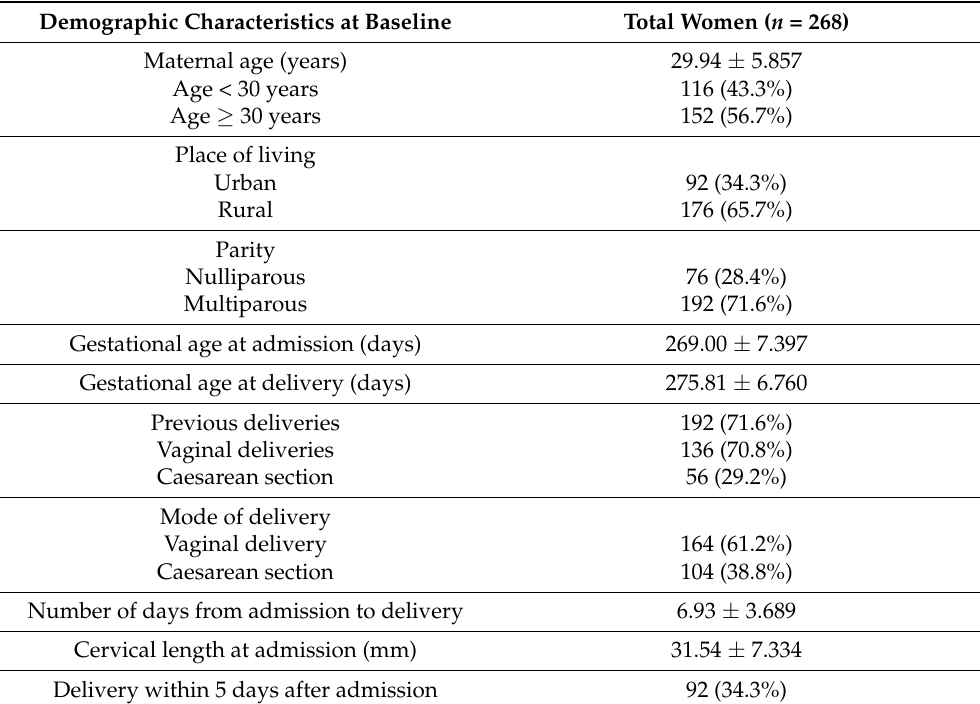
Table 1. Demographic characteristics at baseline.